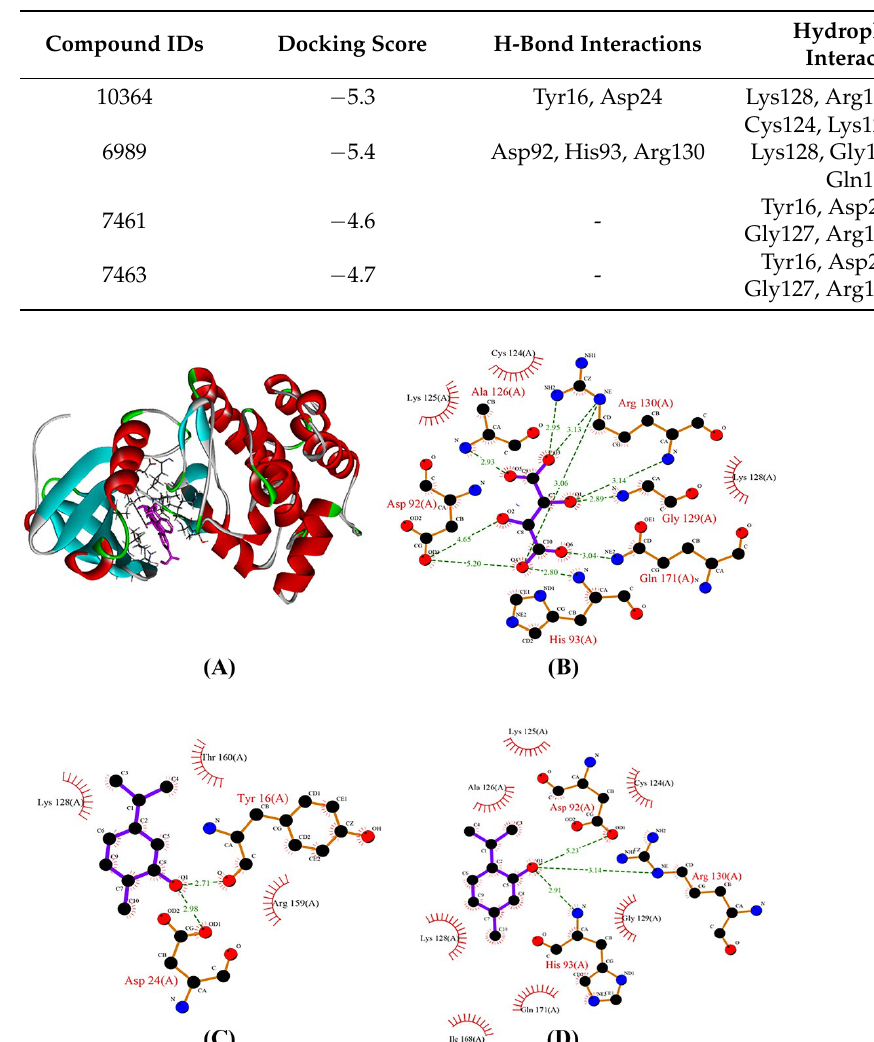
Figure 3. The 3D structure of PTEN bonds efficiently with the main compounds of OEO and TLA ( A ). Protein–ligand interaction profile of PTEN Tumor Suppressor Protein (PDB: 1D5R) with TLA ( B ), carvacrol ( C ), and thymol ( D ). Interactions are shown as colored lines: H-bond in target, green line–hydrophobic interaction, red colored lines. Table 4. Interaction of OEO compounds with PTEN.